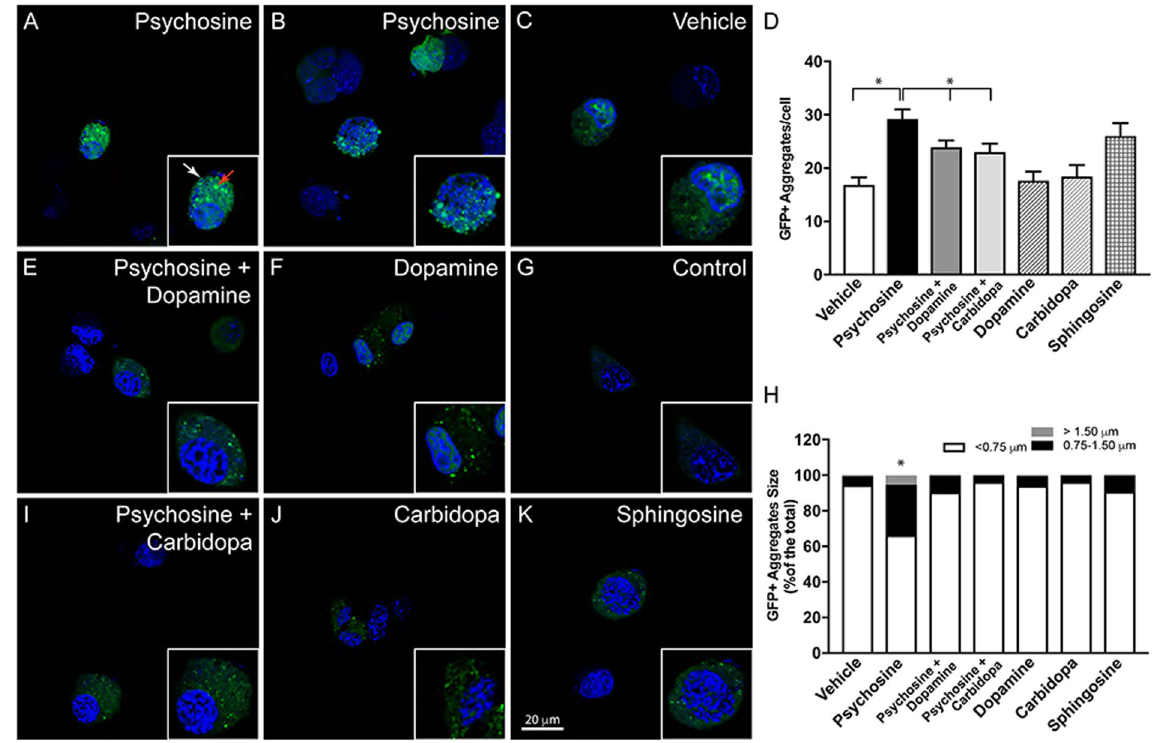
Figure 8. Dopamine and carbidopa prevent psychosine-induced aggregation of α -synuclein. NSC34 motor- neuron cells expressing GN-linkaSYn and a-Syn-GC plasmids 46 were used to study α -synuclein by bimolecular fluorescence complementation (BiFC). Psychosine (1 μ M) was added to NSC34 cell cultures and the formation of fluorescent aggregates of GN-linkaSYn and a-Syn-GC ( A , B ) over basal levels in vehicle-treated cells ( C ) was visualized using confocal microscopy. Psychosine facilitated the formation of medium (0.75–1.50 μ m, white arrow in A) and large ( > 1.5 μ m, red arrow in A ) fluorescent aggregates. Addition of 10 μ M dopamine to psychosine-medium visually prevented aggregation of BiFC fluorescent α -synuclein ( E ). Bar, 20 μ m. Dopamine alone showed insignificant changes in aggregation ( F ). Similar to dopamine, addition of carbidopa in the psychosine-medium blocked the aggregation mediated by psychosine ( I ), with insignificant changes in control conditions ( J ). Sphingosine (1 μ M) was used as a control lipid with non-significant differences from basal levels of aggregation. Panel G shows background fluorescence in non-transfected NSC34 cells. Confocal imaging permitted assessment of GFP + aggregates per cell ( D ) and the distribution of sizes ( H ). Significance, * p < 0.05, ANOVA; mean ± standard error of the mean from 3 independent experiments done in